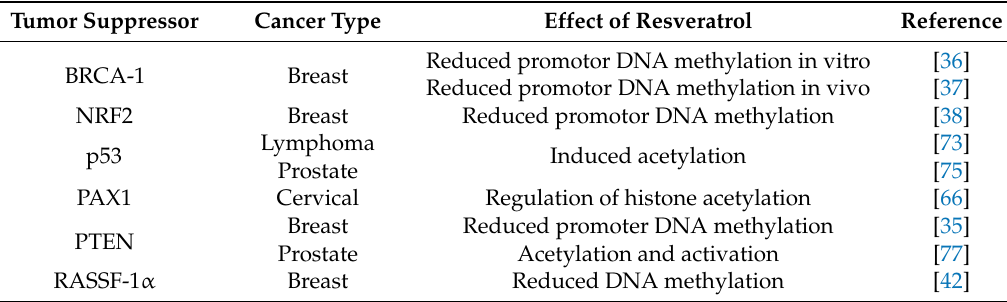
Table 1. Epigenetic effects of resveratrol on tumor suppressors: mechanisms of their re-activation. Tumor